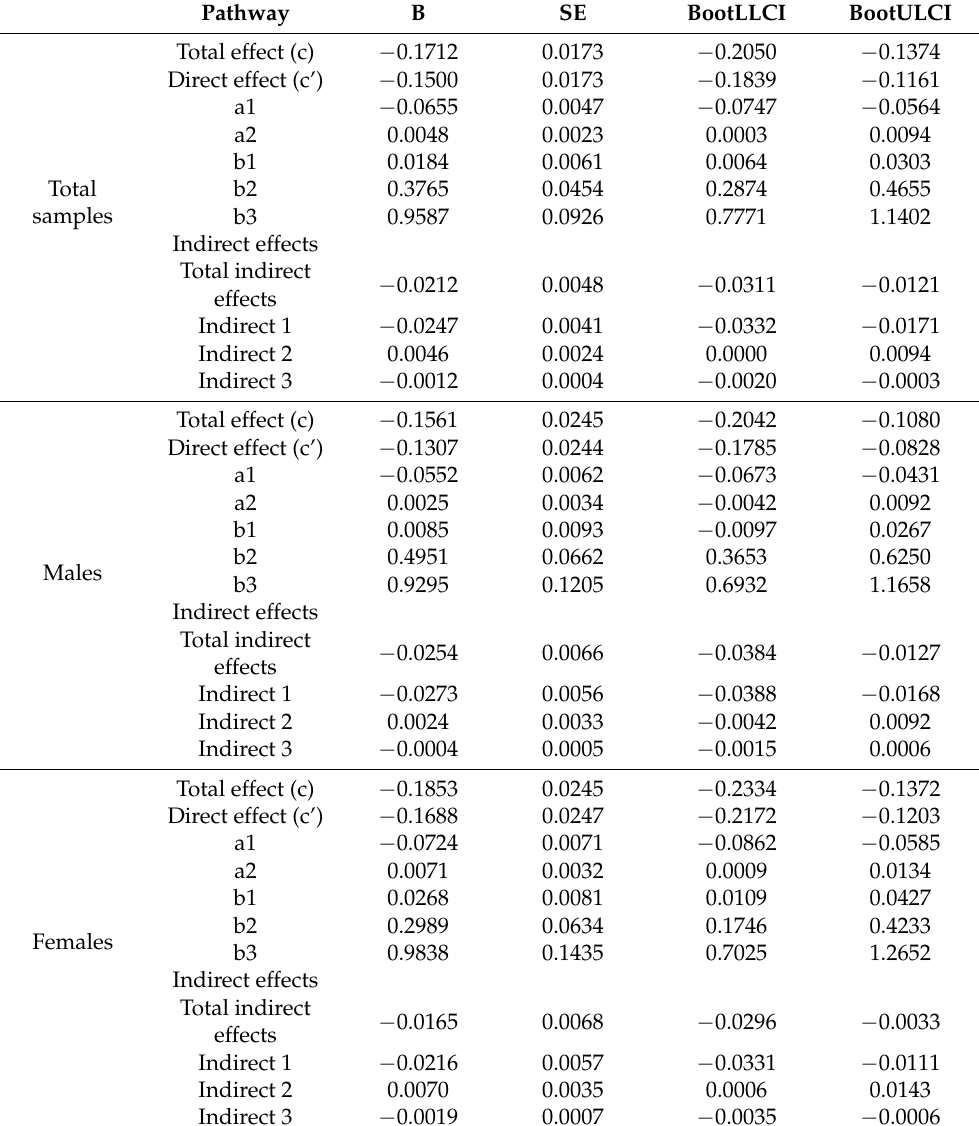
Table 3. Hypothesized serial mediation model of cognitive function, IADL disability, life satisfaction, and depressive